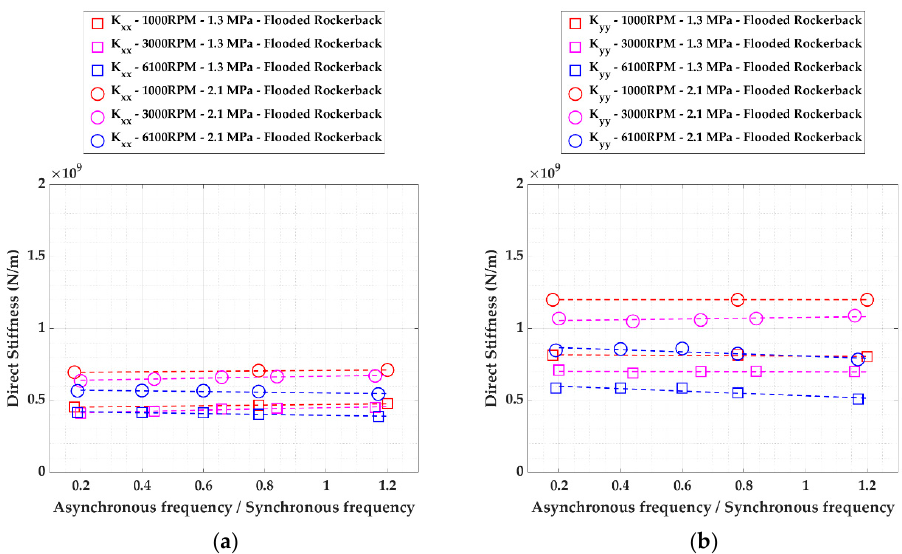
Figure A1. Flooded Rocker Pivot bearing asynchronous direct stiffness coefficients at various speeds for 1.3 MPa and 2.1 MPa: ( a ) K xx , ( b ) K yy .